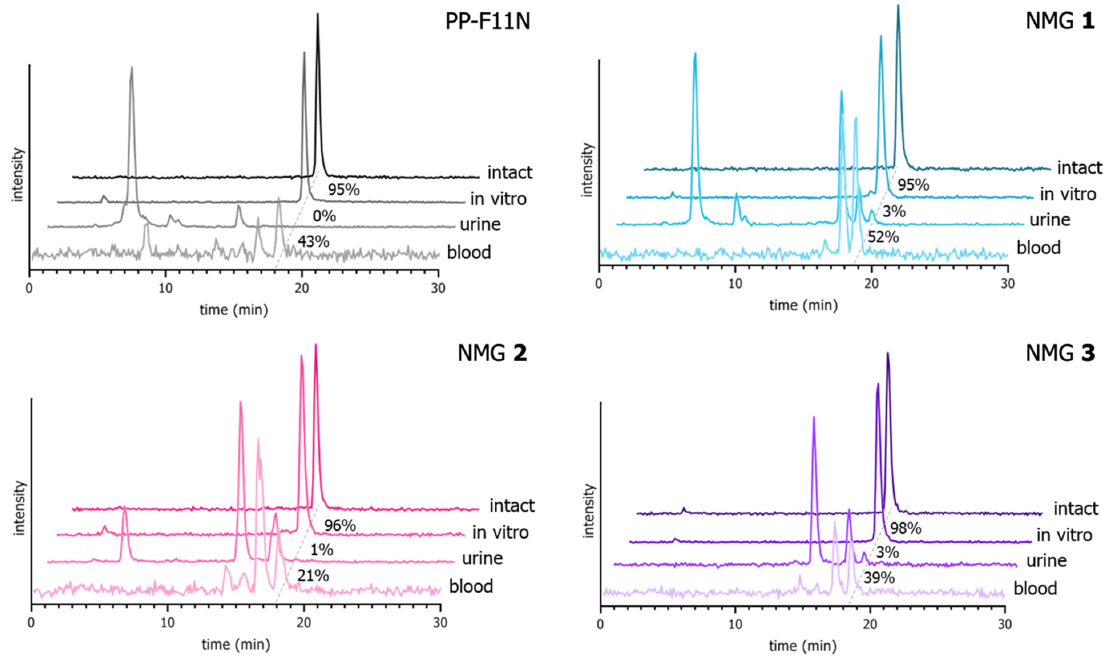
Figure 3. Representative γ -chromatograms of intact 177 Lu-labeled conjugates and samples of blood and urine at 10 min p.i. in vivo and after 24 h of incubation in plasma in vitro for 177 Lu-labeled PP-F11N and NMGs show that the compounds are stable in in vitro stability experiments, but are rapidly degraded upon i.v. injection. Furthermore, urine samples show that only negligible amounts of intact radiolabeled peptides are excreted renally. A dashed line shows the retention time of intact conjugates; numbers beside the dashed line stand for mean percentage of intact conjugate ( n = 2–3).